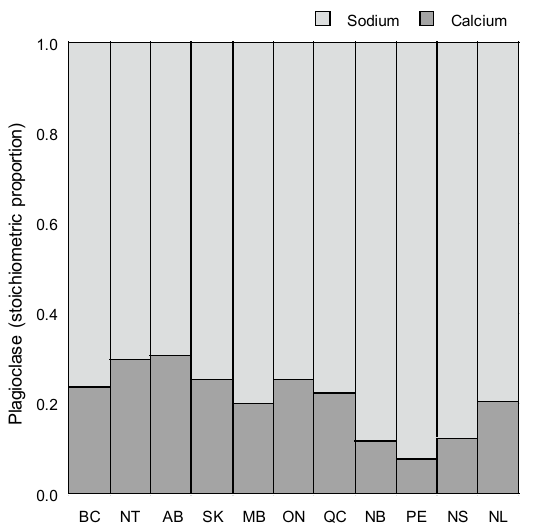
Figure 6. Distribution of the plagioclase stoichiometric ratio for sodium (Na) and calcium (Ca), from west to east by province across Canada from the North American Soil Geochemical Landscapes Project and Trent University Soil Archive ( n = 1170).